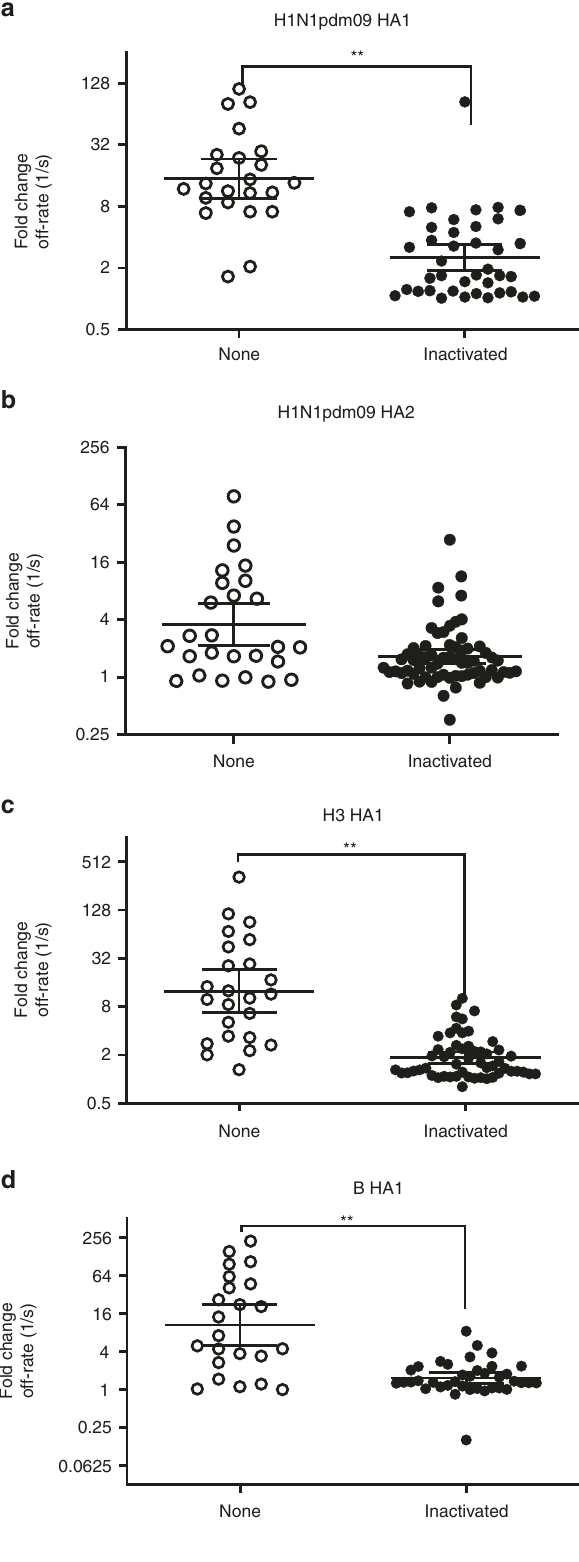
Fig. 6 Prior year vaccination negatively impacts af fi nity maturation of antibodies. a – d Sequential SPR analysis of human in fl uenza vaccine sera (pre- and post-vaccination) was performed against H1N1pdm09 HA1 ( a ) and HA2 ( b ) domains, H3N2 HA1 ( c ), and B-HA1 ( d ). Ten-fold, 50- and/or 250-fold diluted individual serum at pre-vaccination and following vaccination with FluBlok, FluCelvax, or Fluzone from individuals who received inactivated seasonal in fl uenza vaccine in prior year (Inactivated) and individuals who were not vaccinated with in fl uenza vaccine in the previous year (None). Serum antibody off-rate constants were determined as described in Methods. Increase in serum antibody af fi nity as measured by fold change in antigen – antibody complex dissociation rates was calculated as described in Fig. 5 [1/(off-rate on Day 28/off-rate on Day 0)] against H1N1pdm09 HA1 ( a ) and HA2 ( b ) domains, H3N2 HA1 ( c ) and B- HA1 ( d ) for each subject. Geometric means with 95% con fi dence intervals are shown. The pairwise comparison was analyzed using the Mann – Whitney non-parametric method between two groups. The signi fi cance between groups that are statistically signi fi cant with a p value of <0.005 (**) are shown. Source data are provided as a Source Data fi